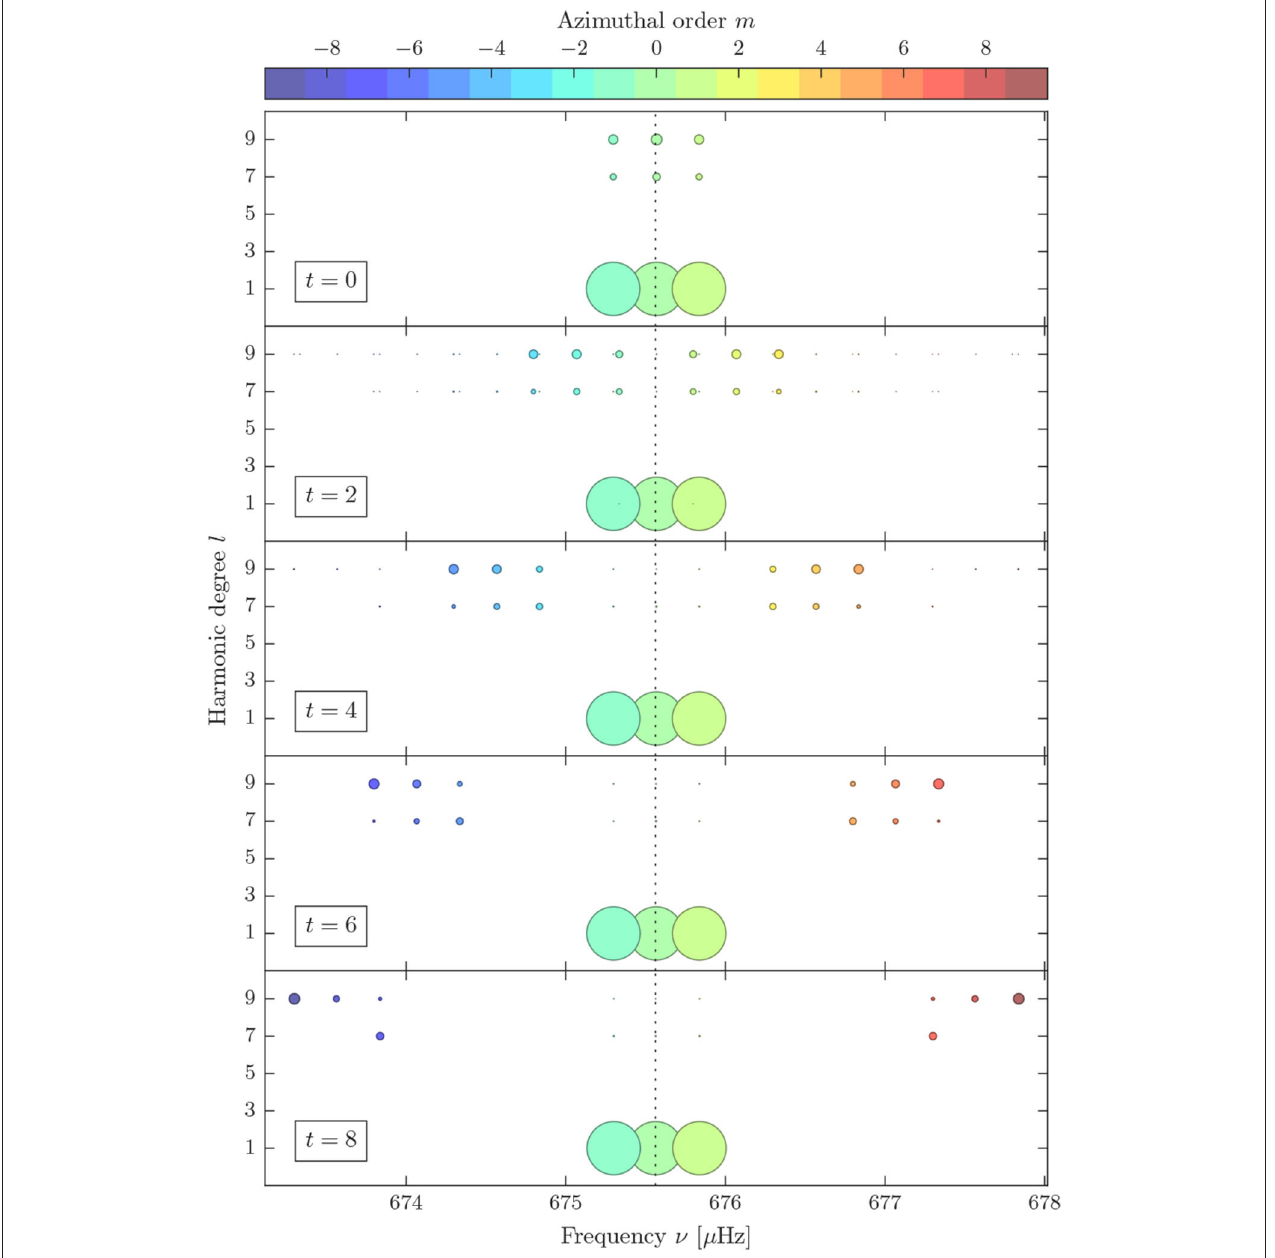
FIGURE 9 | Frequencies and relative amplitudes η k lm (dot size) of the multiperiodic signal for the perturbed l flow with s 8, t 0,2,4,6,8 and an amplified flow profile. Dot colors indicate different values of m . The dotted line marks the unperturbed multiplet frequency = = ν ref 675.6 µ =